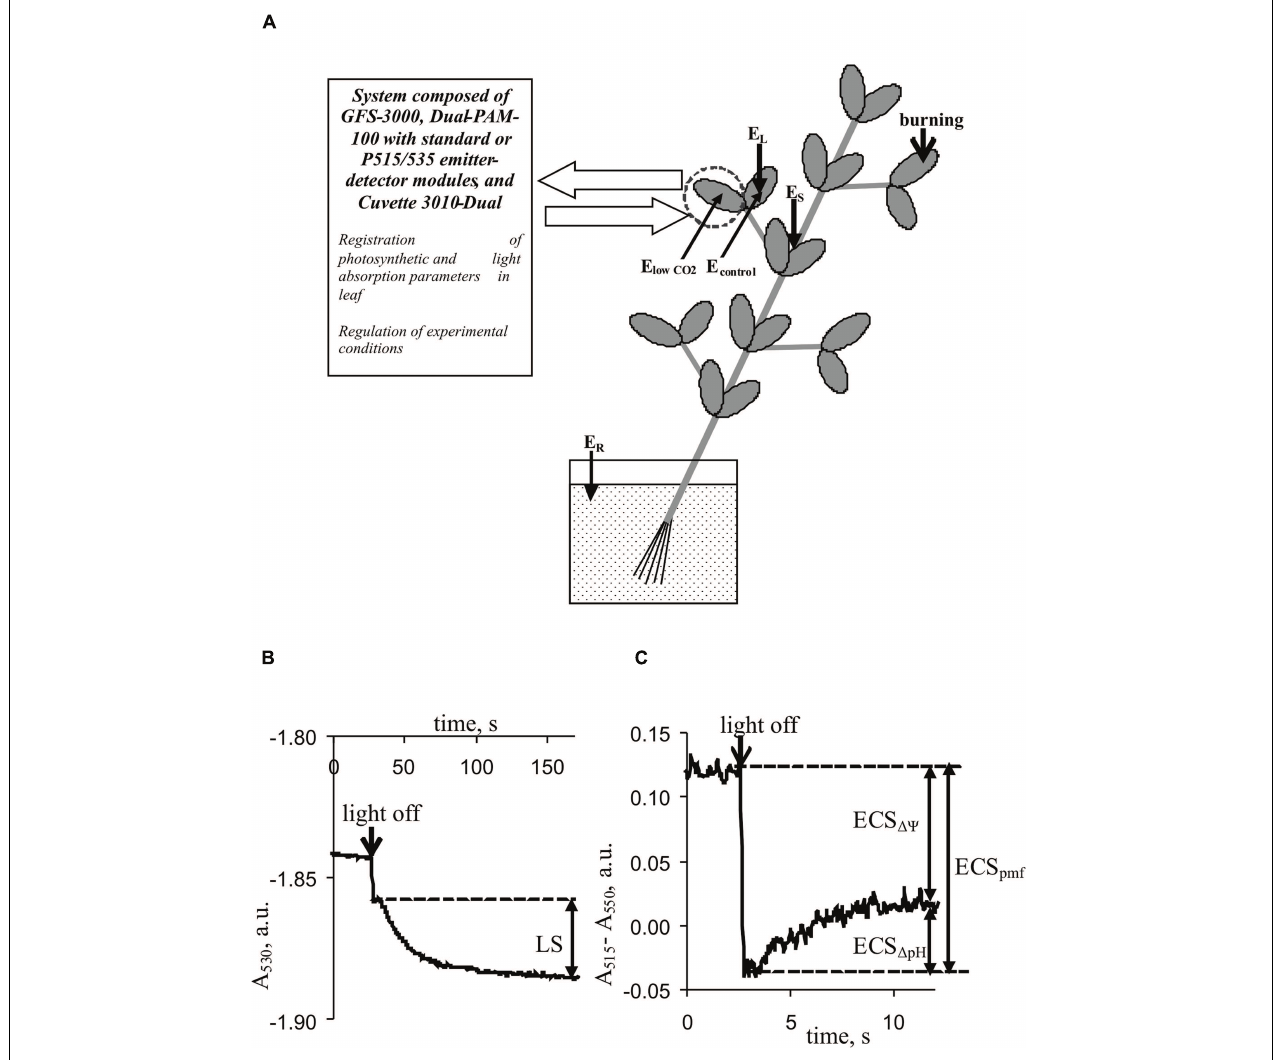
FIGURE 1 | Positions of burning (flame, 3–4 s, ∼ 1 cm 2 ), electrical potential monitoring, and photosynthetic and light absorption parameter measurements in plants. (A) E L and E S , Ag + /AgCl electrodes connected to the leaf and stem, E R , reference electrode; distance between E L and E S , 3–4 cm. E low CO and E control , electrodes from silver wire. (B) Kinetics of leaf light absorption at 530 nm, A 530 . (C) Kinetics of differences between light absorption at 515 nm 2 and absorption at 550 nm, A 515 –A 550 . LS, light scattering; ECS pmf , ECS (cid:49)(cid:57) , and ECS (cid:49) pH represent electrochromic pigment absorbance shifts proportional to the proton motive force, transmembrane electrical potential, and proton gradient on the thylakoid membrane, respectively.